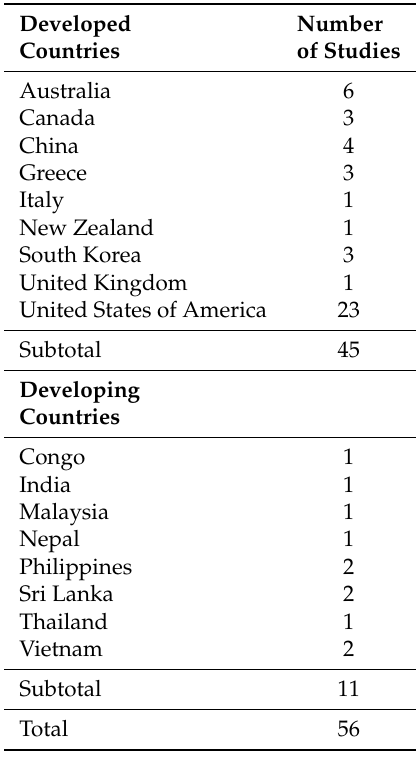
Table 2. Geographical distribution of